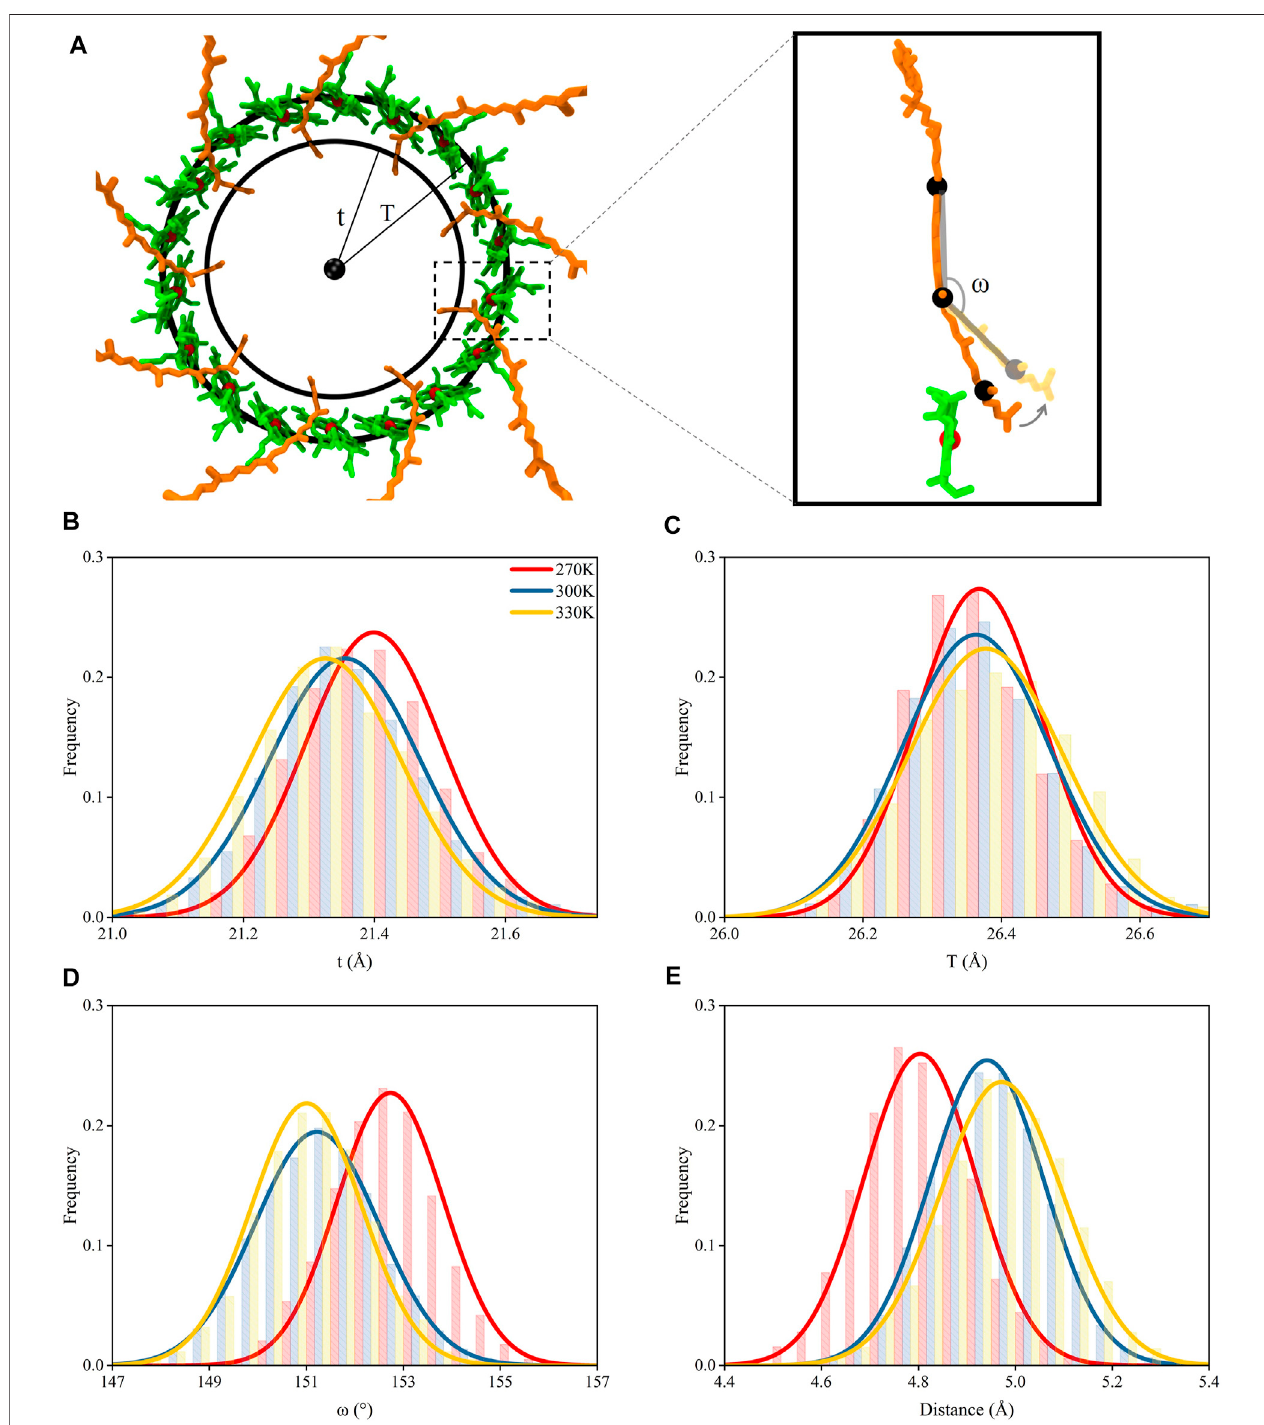
FIGURE5| Movementsofpigmentmolecules. (A) TopviewofringsformedbyB850andthetailofRG1molecules.Theradiioftheringformedbythemasscenters of C21 – C30 atoms in the tail of RG1 is noted as “ t ” and the radii of the ring formed by the mass center of porphyrin rings in B850 molecules is noted as “ T ” . The inset displayed the ω angle (measured with mass centers of C9 to C13, C18 to C22, and C26 to C30 atoms, consecutively) change with relation to the distance change between RG1 and B850 molecules (B) Distributions of t under different temperatures. (C) Distributions of T under different temperatures. (D) Distributions of ω angle under different temperatures. (E) Distributions of closest distances between RG1 and B850 molecules under different temperatures.